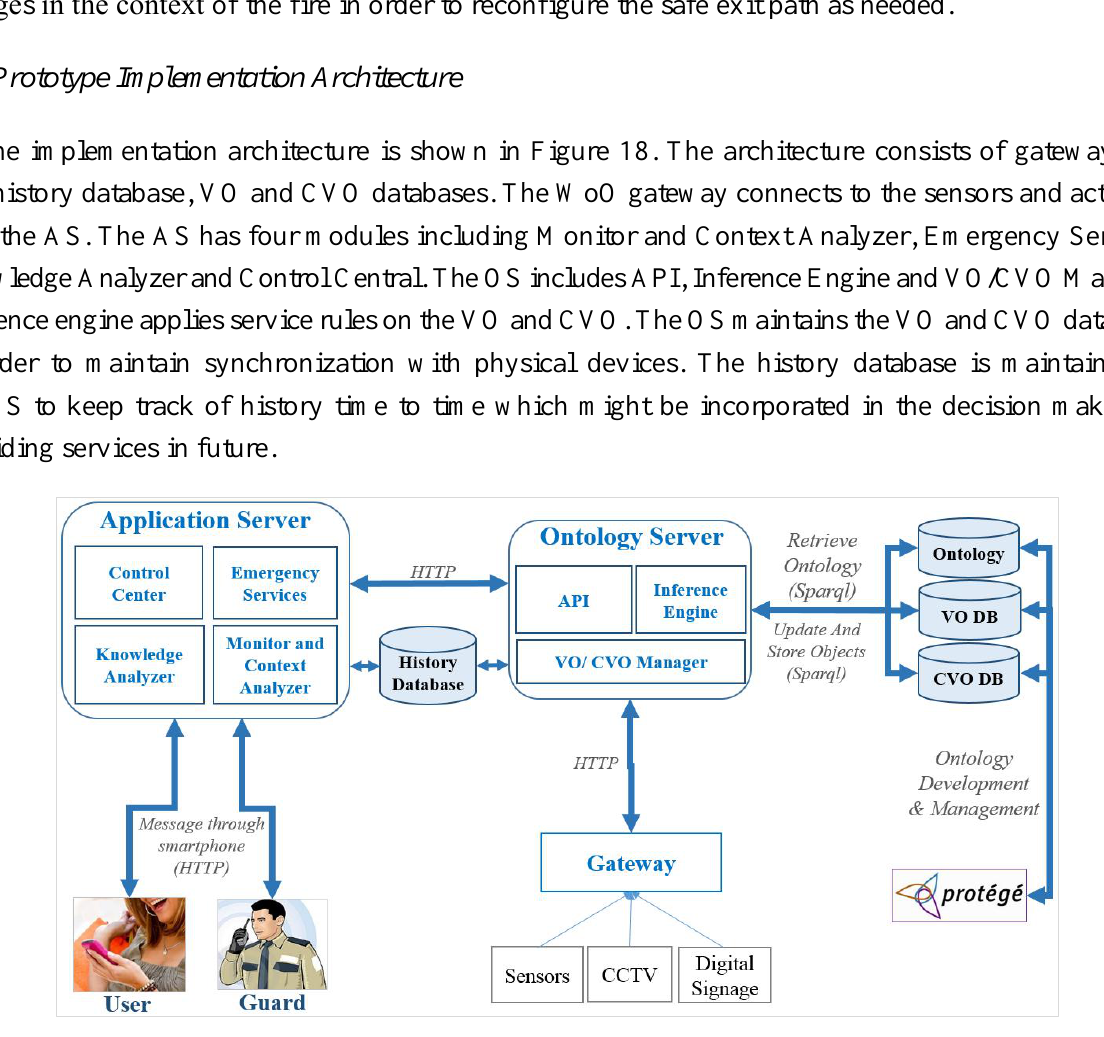
Figure 18. Implementation architecture for the use case